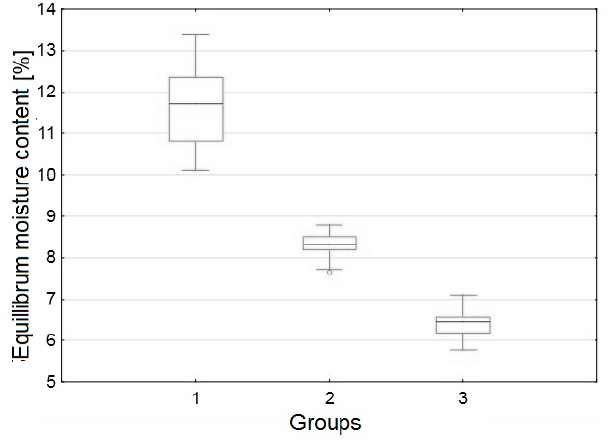
Figure 4. EMC of specimens: group no.1—unmodified specimens; group no.2—specimens modified at 180 ◦ C; group no.3—specimens modified at 200 ◦ C. EMC at 60% air humidity. ◦ —outlier